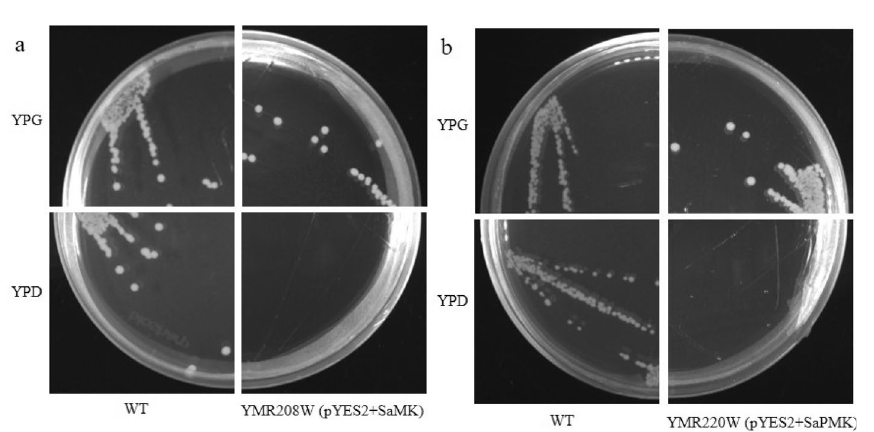
Figure 6. Functional complementation of SaMK ( a ) and SaPMK ( b ) genes in Santalum album . The strains were grown on YPG and YPD medium at 30 °C for 3 days with the exception of YMR208W with SaMK and YMR220W with SaPMK